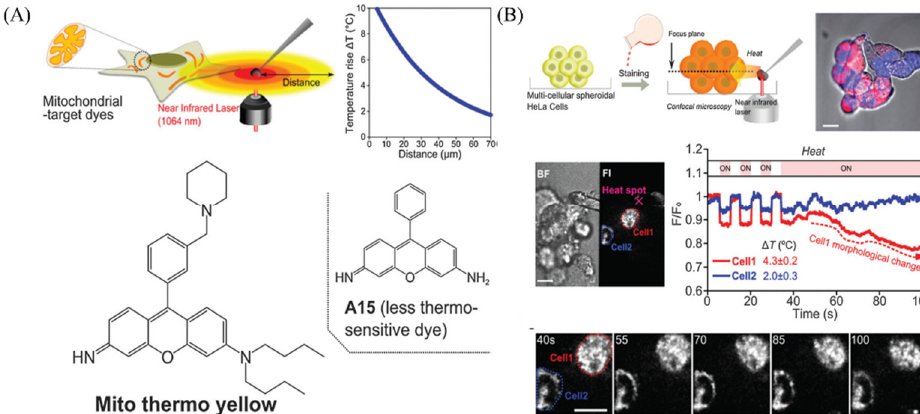
Figure 23. ( A ) The imaging systems to visualize temperature sensitivity and structure of probe Mito thermos yellow. ( B ) Monitoring the temperature with probe Mito thermos yellow, and the images and time course of fluorescence intensity in multi-cellular spheroidal HeLa cells. Reproduced from [114] with permission of the Royal Society of Chemistry, copyright 2015.